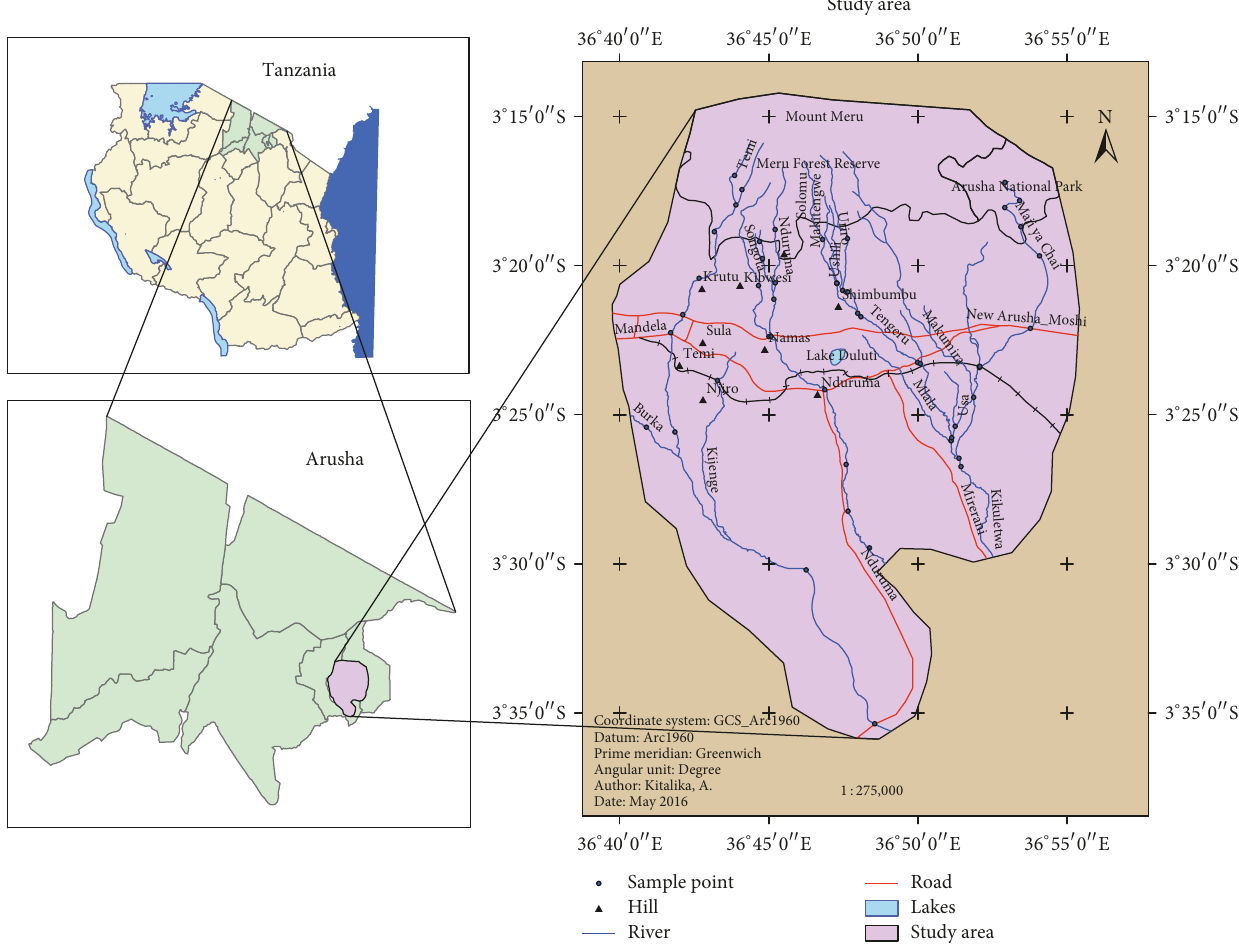
Figure 1: Location of the study